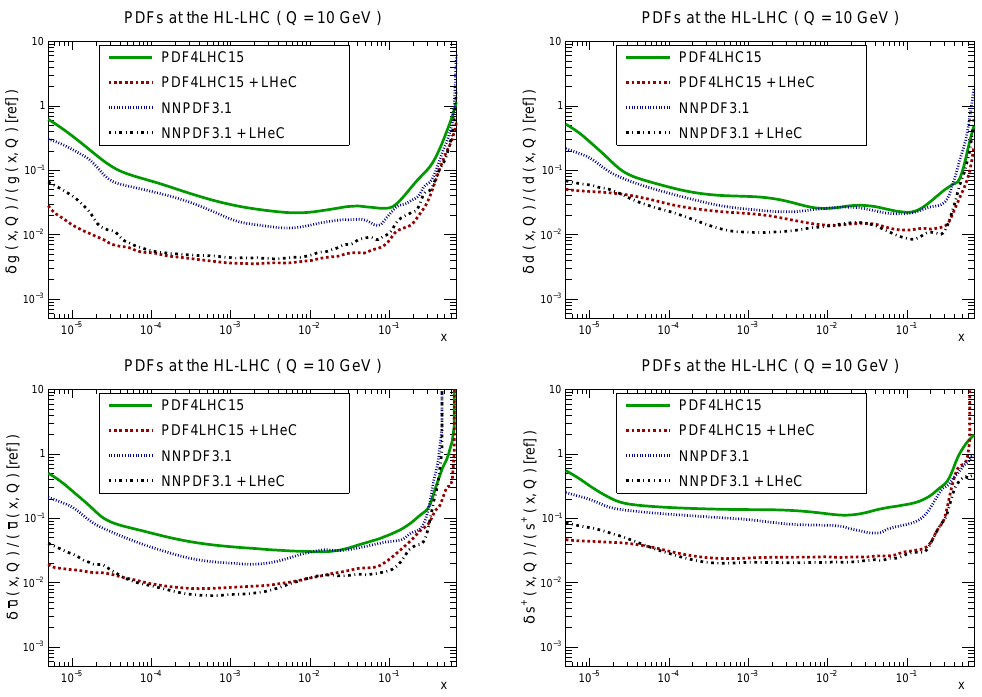
Figure 4.3: Same as Fig. 4.1 for the complete LHeC dataset, with the result of profiling the NNPDF3.1 Hessian set also